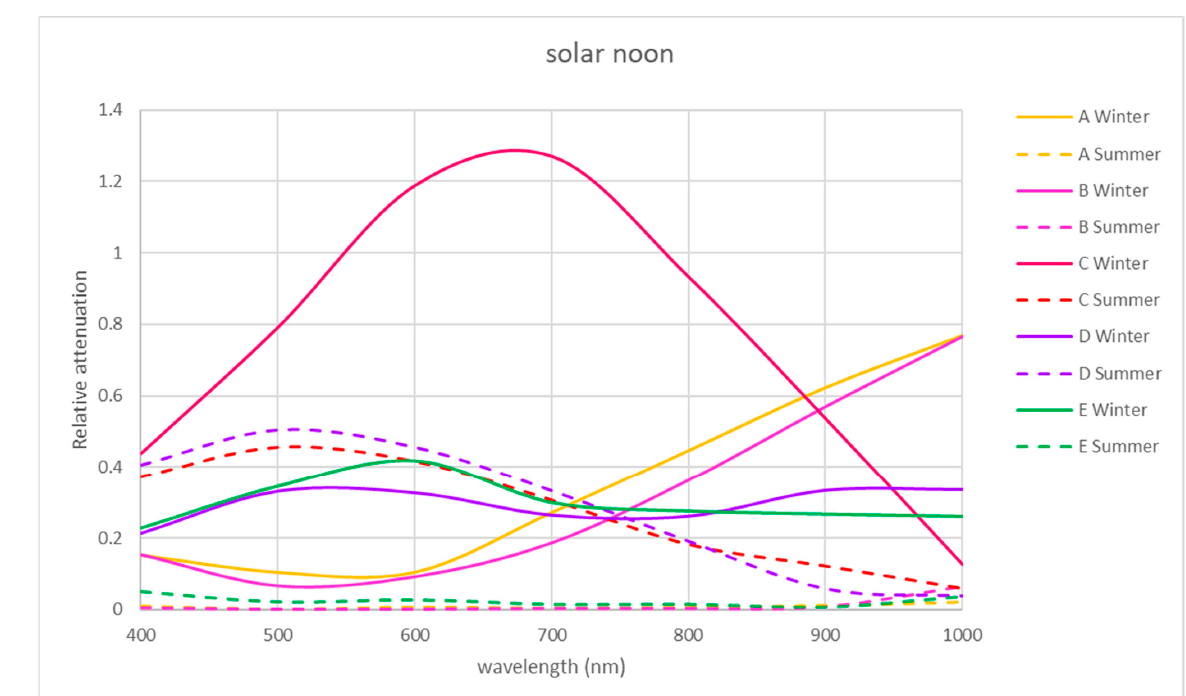
Figure 9. Representation of the spectral relative attenuation for the VIS and NIR bands for the 5 locations studied in two seasons of the year at solar noon.